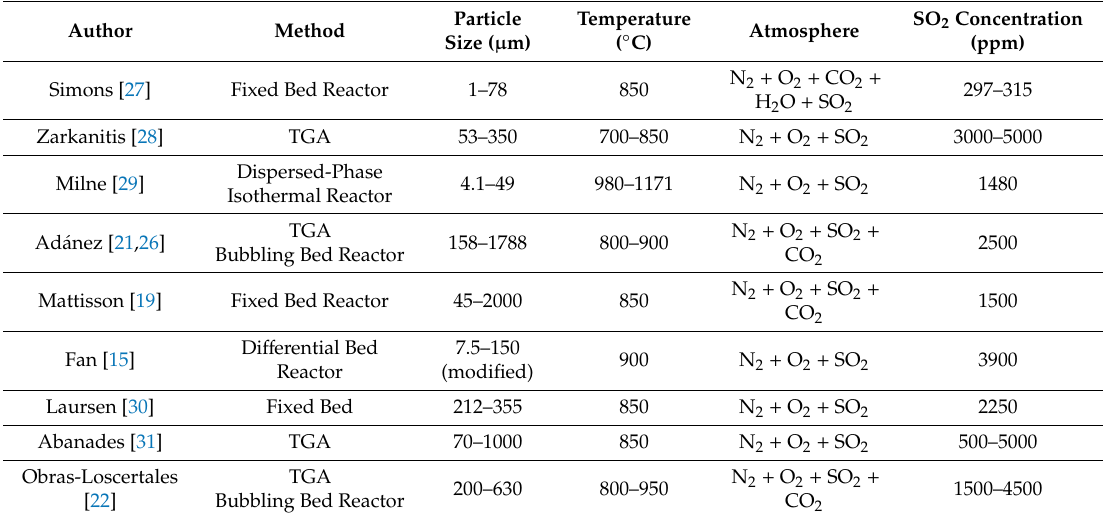
Table 1. A brief summary of investigations of a broad range of particle sizes under atmospheric